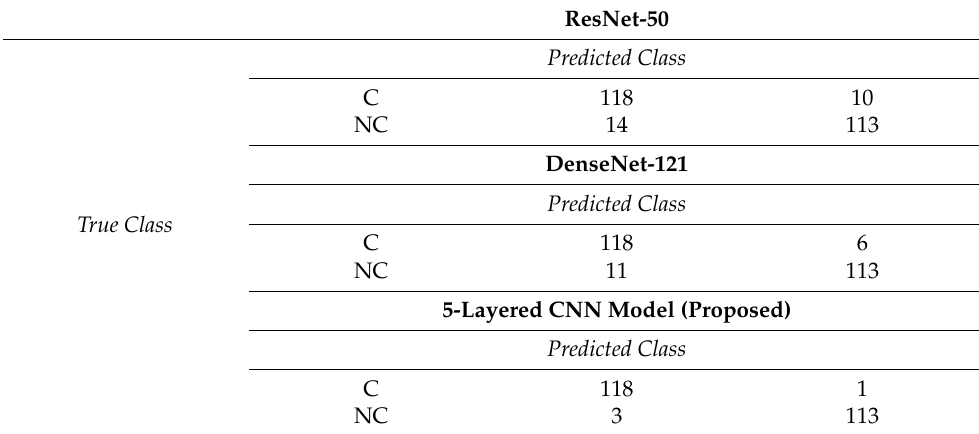
Table 4. Acquired Confusion Matrix of ResNet-50, DenseNet-121, and the Proposed Five-layered CNN Model.